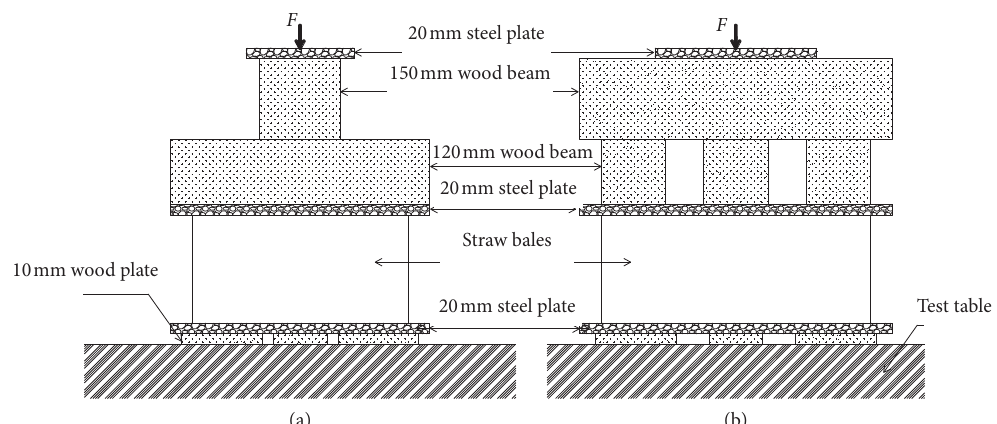
Figure 5: The experimental setup of unplastered straw bales. (a) Front elevation. (b) Side